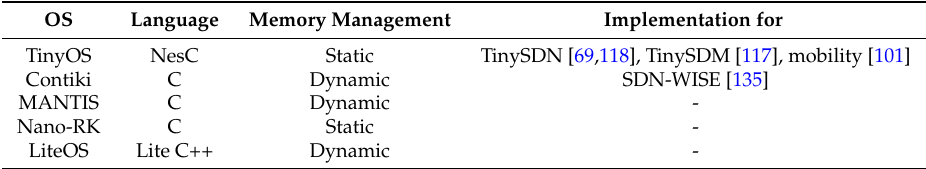
Table 4. Enabling node operating systems for SDN-based management of WSNs: A